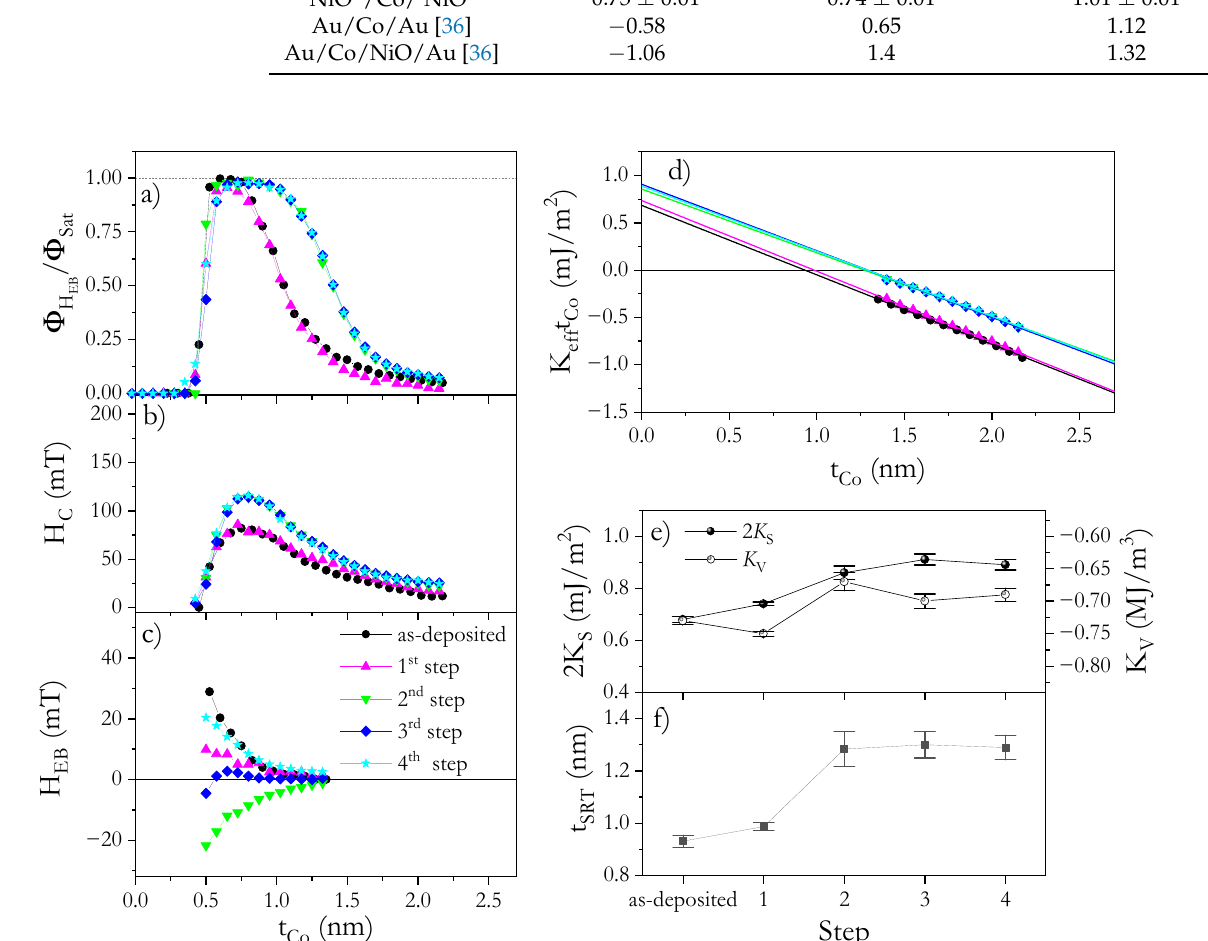
Figure 5. Normalized Kerr signal ( φ H / φ Sat ) at H = H EB ( a ), coercivity ( H C ) ( b ) and exchange bias field ( H EB ) ( c ) as functions of Co layer thickness for NiO b /Co/Au. Product of effective magnetic anisotropy and Co thickness ( K eff t Co ) as a function of t Co ( d ) for NiO b /Co/Au in the as-deposited state and after different FC steps. Volume and surface anisotropy constants ( e ) and SRT thickness ( f ) for NiO b /Co/Au in the as-deposited state and after four different FC steps (1st—350 K, +170 mT; 2nd—450 K, +170 mT; 3rd—350 K, − 170 mT; 4th—450 K, − 170 mT). In the case of NiO b /Co/NiO t , we need to consider EB effect contributions from two interfaces simultaneously (NiO/Co and Co/NiO t ), and the fact that EB couplings at each interface are too weak to introduce rotation of the Co spin across the film thickness if the EB coupling direction at both interfaces is opposite. This is due to the small thickness and higher exchange and anisotropy energies than EB coupling energy. Since after the first step of FC we found that the H EB for NiO b /Co/Au is slightly larger than for NiO b /Co/NiO t , many more grains at the Co/NiO t interface are coupled along H FC than at the NiO b /Co interface. This means that the grains of NiO b show a lower blocking